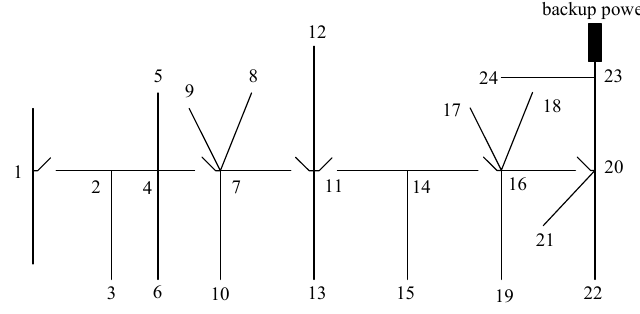
Figure 13. Example 2: optimal switch-distribution map (with contact).